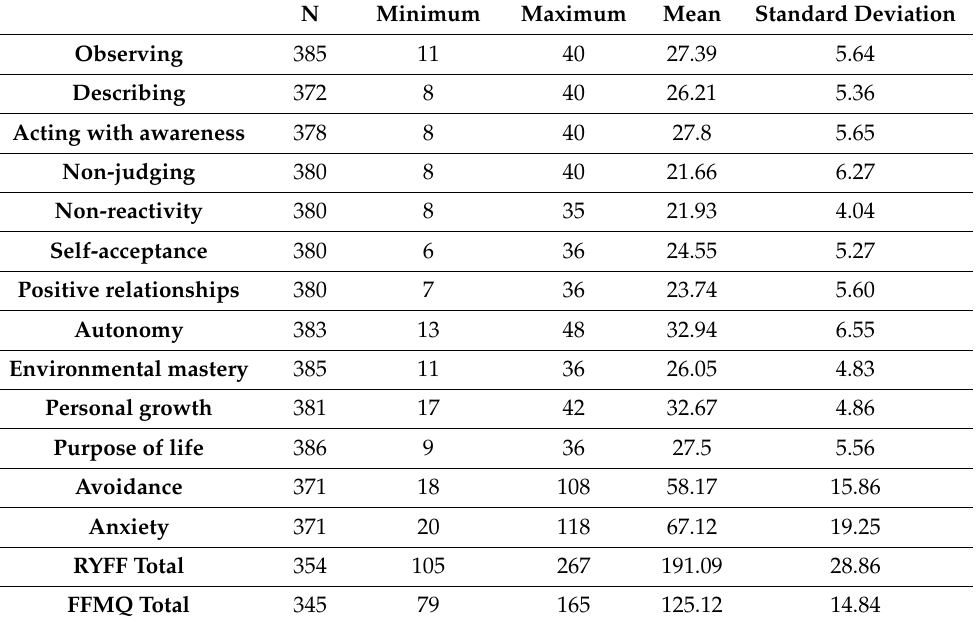
Table 1. Means and standard deviations of the variables of mindfulness, wellbeing, avoidance, and anxiety (N = 391). N Minimum Observing Describing